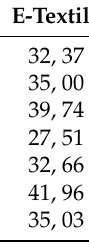
Table 1. Percentage of corrupted signal obtained by means of hand labeling of the two categories of signals: signals recorded by using Ag/AgCl electrodes and signals recorded by using textile electrodes. Ag/AgCl E-Textile